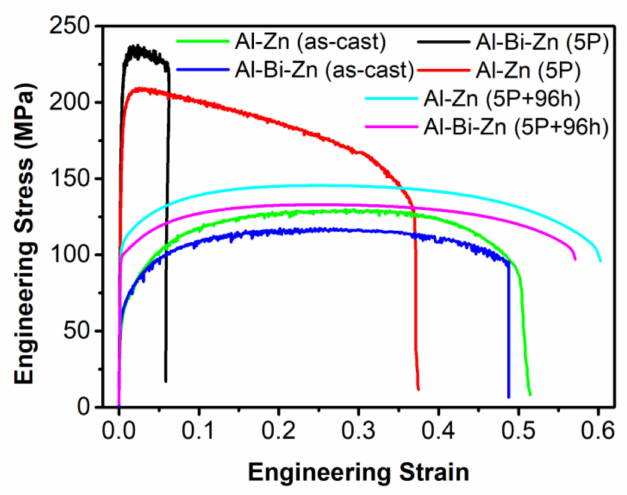
Figure 9. Tensile engineering stress–strain curves of the Al-8Zn and Al-6Bi-8Zn alloys. Table 1. Tensile properties of the as-cast, as-deformed, and annealed Al-8Zn and Al-6Bi-8Zn alloys. Material